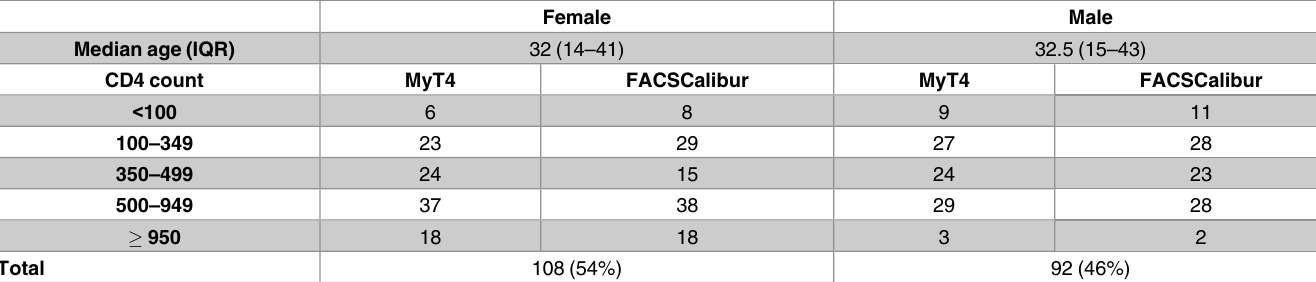
Table 1. Patient sample demographics.